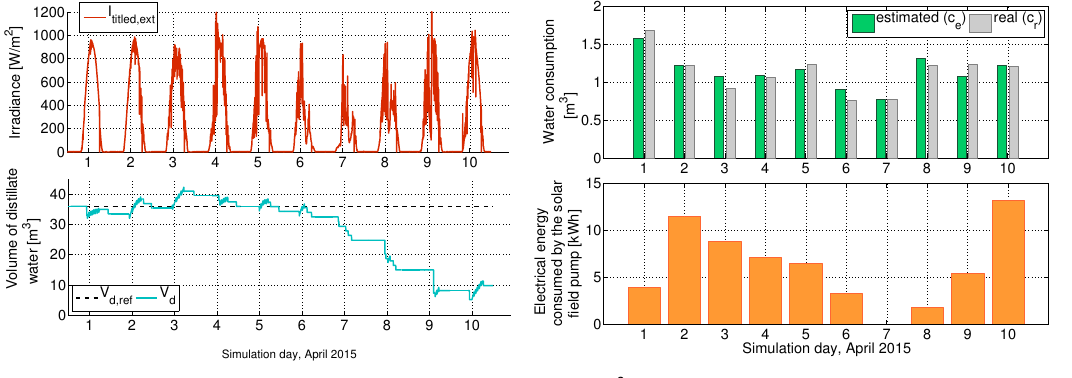
Figure 9. Simulation results obtained during ten days. ( a ) Irradiance and distillate volume; ( a ) 800-m 2 greenhouse water consumption and solar field electrical energy